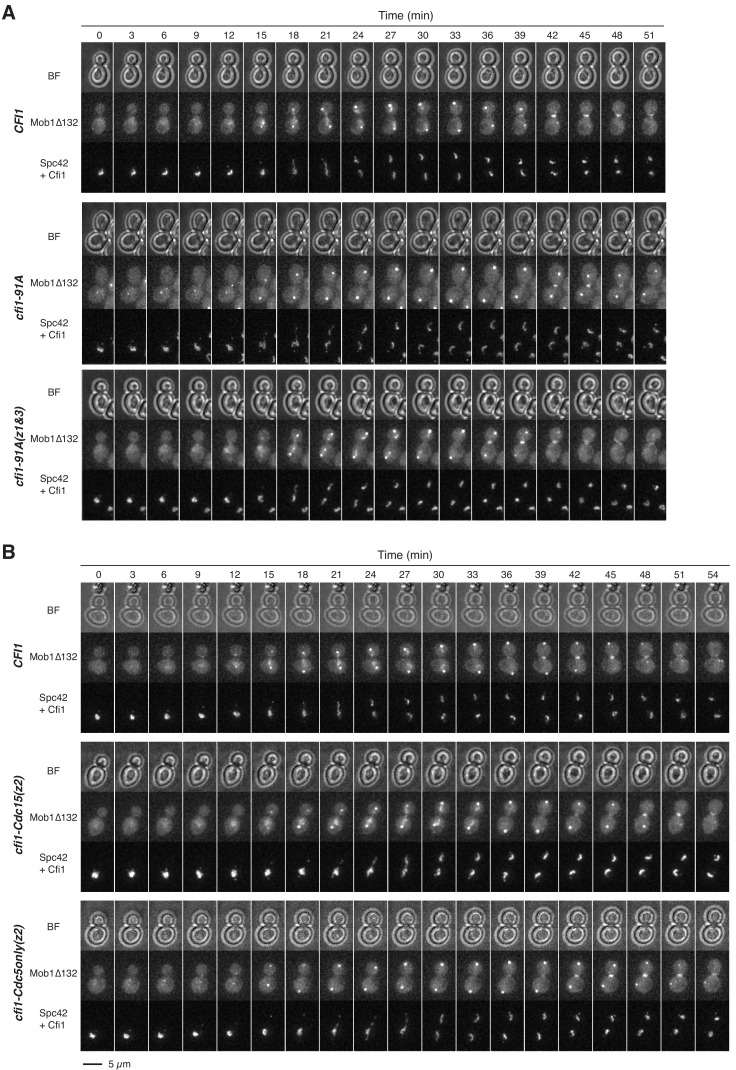
Phosphorylation of Cfi1/Net1 modulates Dbf2-Mob1’s nucleolar localization.(A and B) Representative images of Mob1Δ132 localization in CFI1/NET1 (A41411), cfi1-91A (A41412 and A41413), cfi1-Cdc15(z2) (A41593), or cfi1-Cdc5only(z2) (A41594) cells.